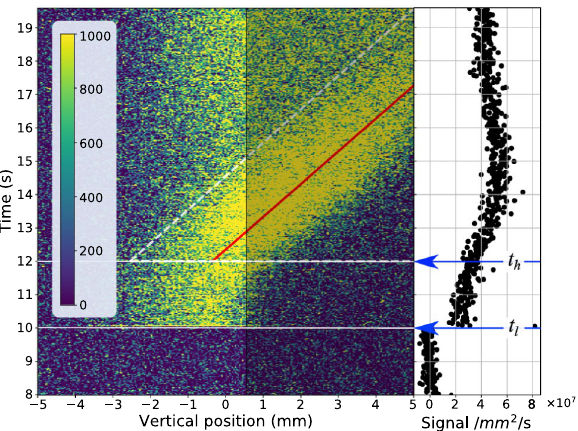
Figure 2. (left) Excimer fluorescence integrated across the horizontal field-of-view per second recorded versus time and vertical position. Only the region for < 0.5 mm is illuminated by the neutron beam. The red line is the best fit to the peak of the fluorescence position vs. time. The inverse of the slope of the red line is the velocity of the flow for a heater power of 7.3 mW (this case). (right) Fluorescence integrated over the entire field-of-view vs. time. The neutron shutter was opened at 5 s, the laser shutter opened at t l = 10 s, and the bottom heater energized at t h = 12